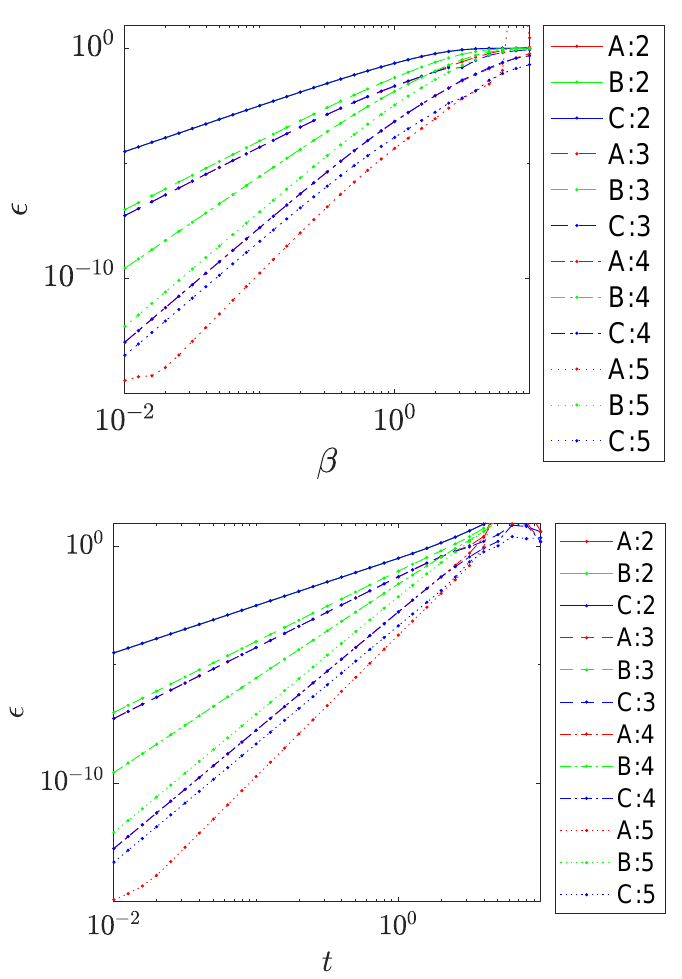
Figure 1: Relative error ε of the cluster-MPO for the 1-D spin-1 / 2 Heisenberg model on a periodic chain of 11 sites. Top panel shows ε for the unnormalized thermal density operator ρ = e − β H , as a function of inverse temperature β . Bottom panel shows ε of the real-time evolution operator U ( t ) = e − iHt , as a function of time t . We show results of the cluster-MPO of types A,B and C with cluster sizes c =